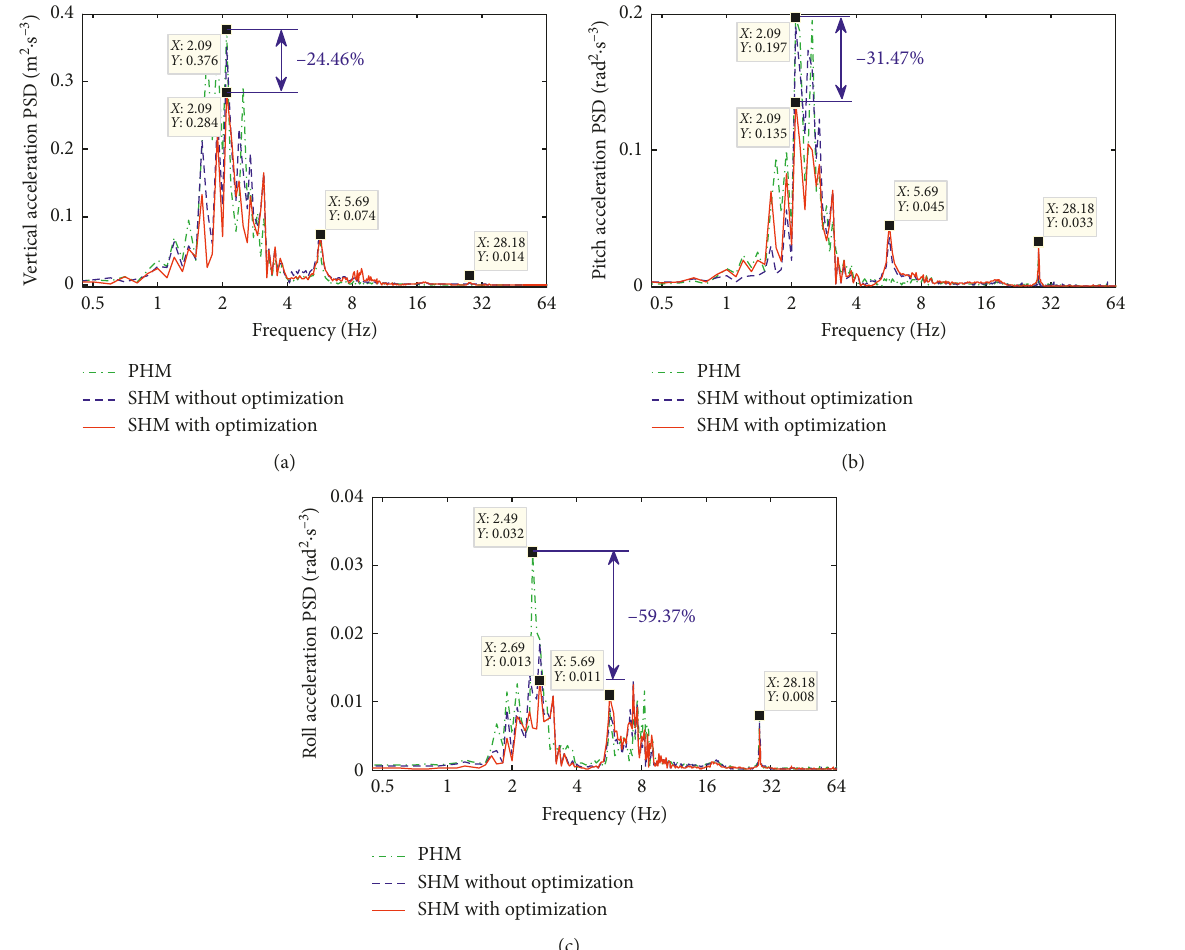
Figure 10: Results of the PSD acceleration responses under a low excitation frequency, 28Hz, of the drum. (a) Vertical driver’s seat. (b) Cab’s pitch angle. (c) Cab’s roll